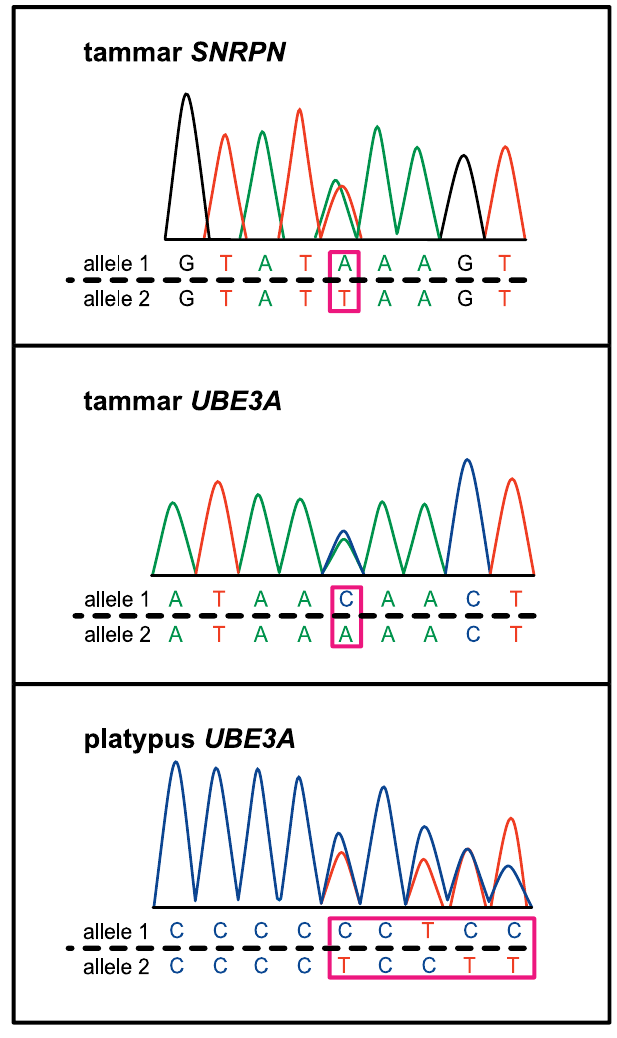
Figure 3. Biallelic Expression Demonstrated by Sequencing Brain cDNA from Heterozygous Animals for Alleles of SNRPN and UBE3A in Tammar Wallaby and UBE3A in